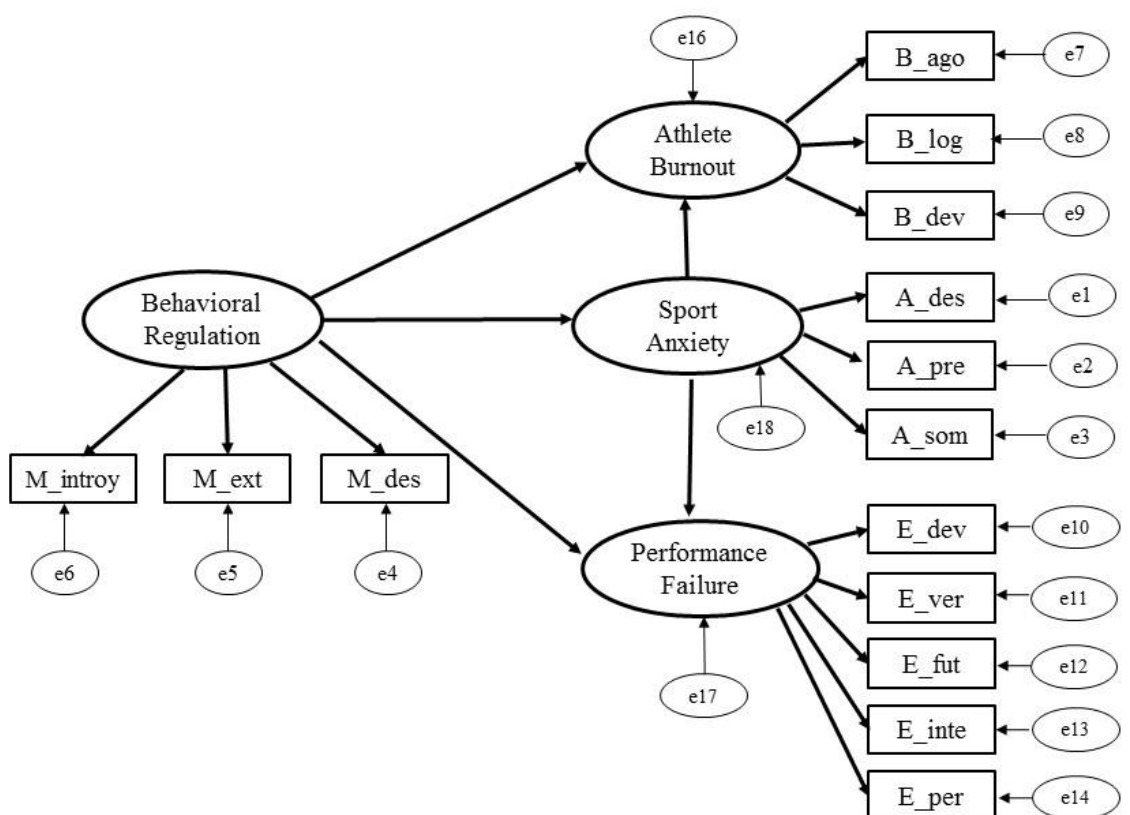
Figure 2. Hypothetical model among Behavioural Regulation, Sport Anxiety, Athlete Burnout and Performance